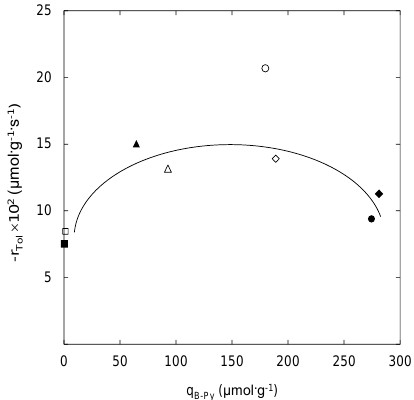
Figure 4. Influence of strong Brønsted acid sites on the toluene ozonation reaction rate. Filled markers represent zeolite samples out-gassed at 623 K and open markers stand for samples out-gassed at 823 K: ( ■ /□) NZ; ( ▲ /∆) ZH2.4; ( ♦ /◊) NH4Z1; (●/ ○ ) 2NH4Z1. Experimental conditions were as follows: m sample = 150 mg; 101 kPa, 293 K; C Tin = 42.3 µmol·cm −3 ; C O3in = 3.57 µmol·dm −3 .